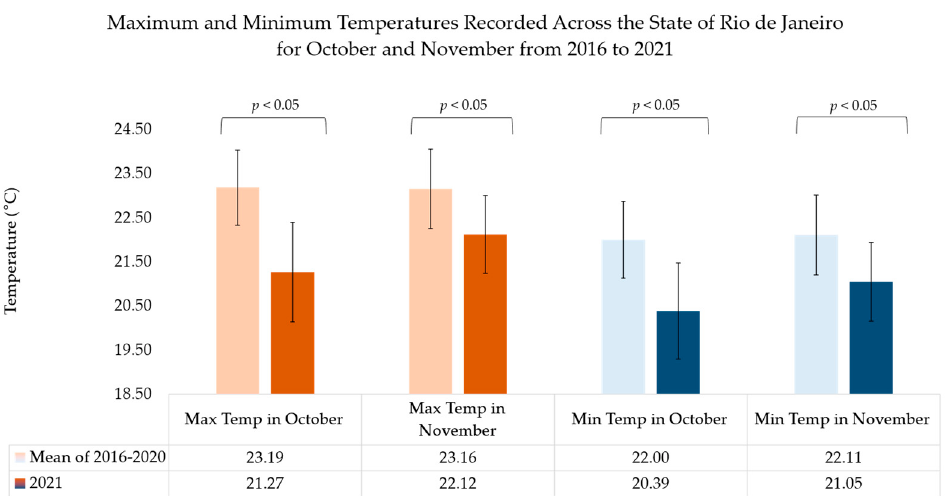
Figure 3. Maximum and minimum temperatures recorded across the State of Rio de Janeiro for October and November from 2016 to 2021. Data from 2016–2020 and 2021 were averaged between ten weather stations covering the State of Rio de Janeiro. The data for the mean of 2016–2020 represent all measurements taken from maximum and minimum temperatures for the ten weather stations in Rio de Janeiro. A Wilcoxon signed rank test was performed comparing 2021 maximum and minimum temperatures for the months of October and November with that of the mean of 2016–2020. Error bars represent standard error. All p -values were <0.001.